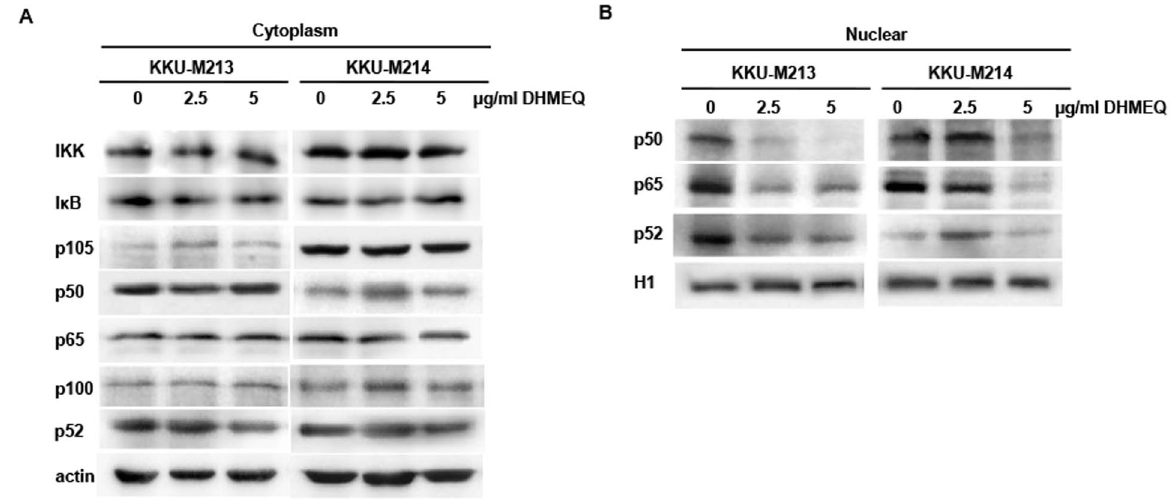
Figure 4. DHMEQ inhibited nuclear translocation of NF- k B in CCA cell lines. Western blot of NF- k B of KKU-M213 and KKU-M214 treated with 2.5 and 5 m g/mL of DHMEQ for 48 h. Protein (10 m g) of A) cytoplasmic fraction and B) nuclear fraction was loaded. Actin and histone H1 were used as internal controls.